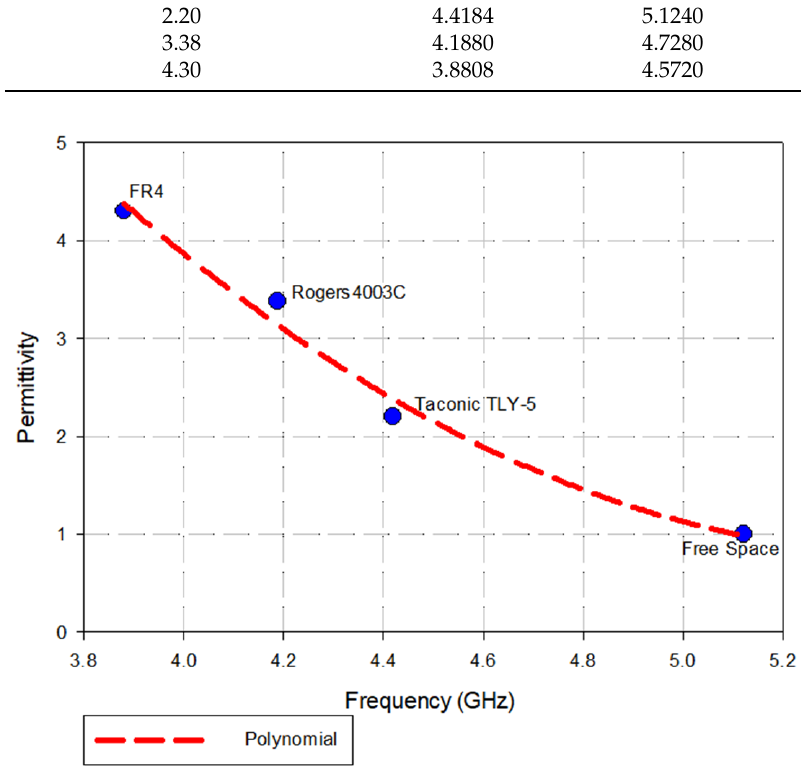
Figure 25. Calibrated frequency (GHz) against permi tt ivity.